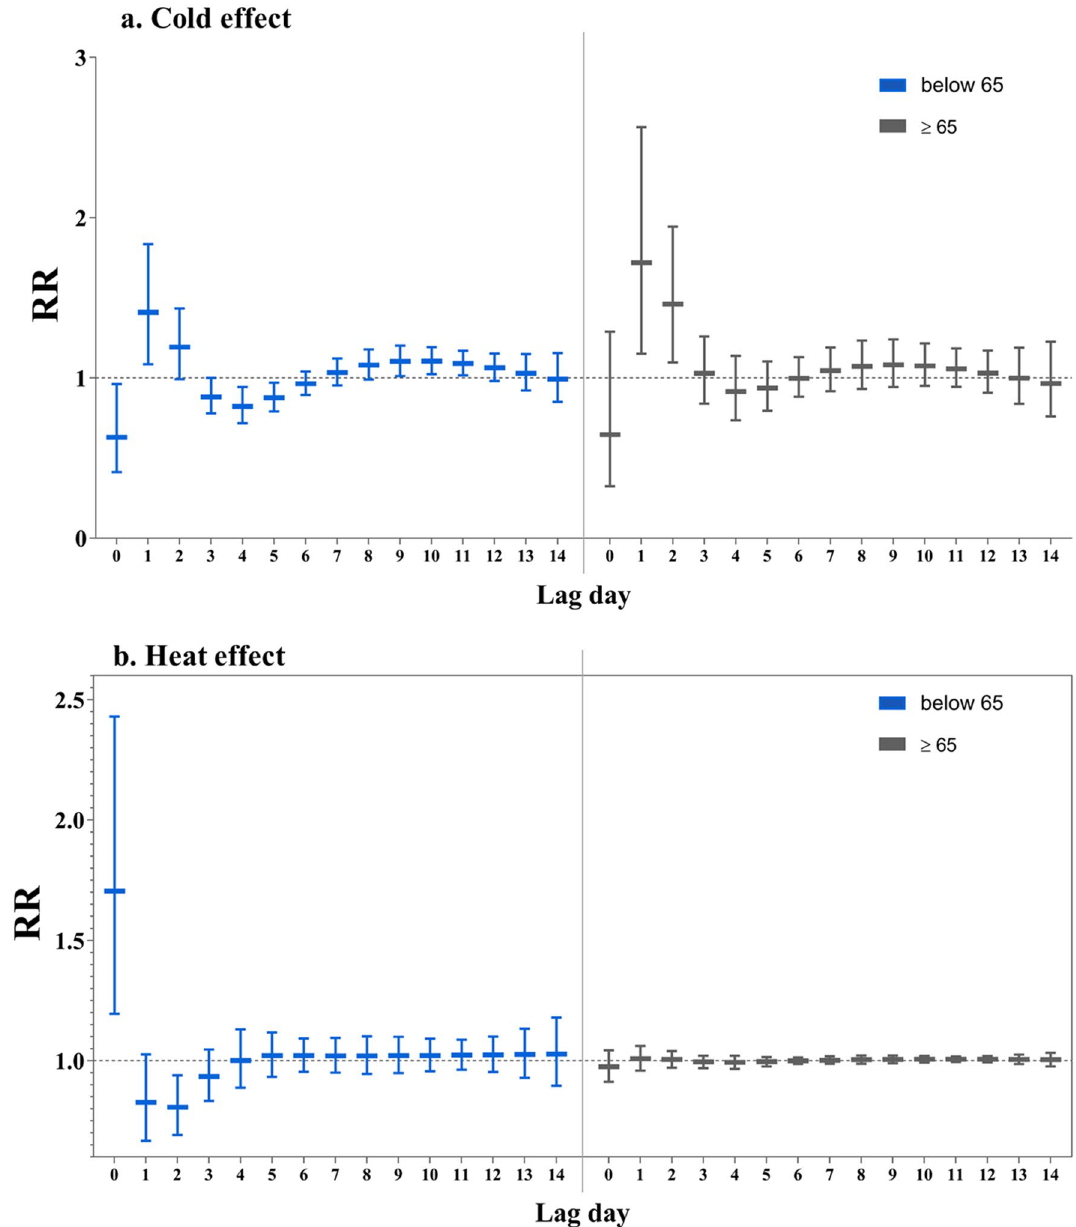
Figure 4. The single day effects of high AT for admissions due to acute cardiac events cross different lag day(s) in age-specific groups, with the reference of the Minimum Admission Apparent Temperature (MAAT) of each group. Notes: MAAT for < 65 group and ≥ 65 group was 20 °C and 33 °C,